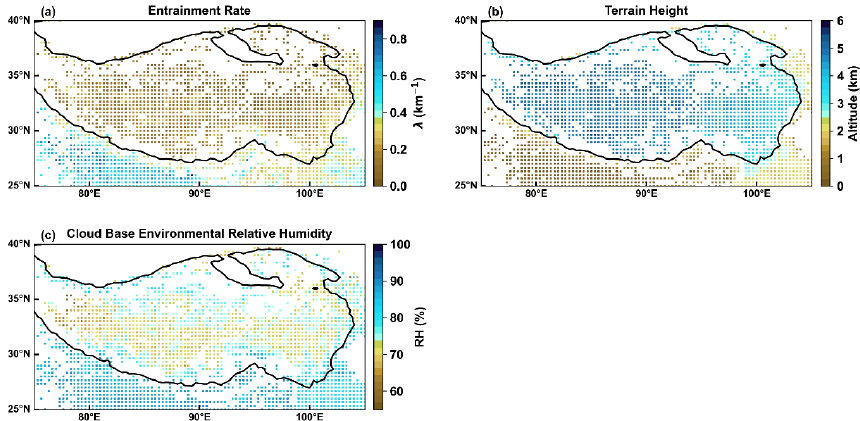
Figure 2. The spatial distributions of the entrainment rate (Panel a ; λ ; units: km − 1 ), terrain height (Panel b ; units: km), and cloud base environmental relative humidity (Panel c ; RH; unit: %) at the convective cloud product grids in the boreal summer from 2013 to 2017; the black lines are the contours of 3 km terrain height.